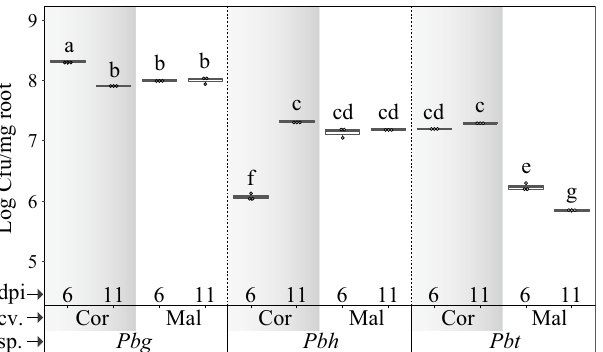
Figure 2. Root colonization ability of strains of three Paraburkholderia species (sp) for two Broccoli cultivars (cv) at 6 and 11 days post inoculation (dpi). Means of 3 replicates are shown. Treatments sharing the same letter are not significantly different based on three-ways ANOVA (dpi, Broccoli cultivars and Bacteria species, Tukey’s HSD post hoc test, P < 0.05). Broccoli cultivars (Cor: Coronado, Mal: Malibu) and Paraburkholderia species ( Pbg : Paraburkholderia graminis PHS1, Pbh : P. hospita mHSR1, and Pbt : P. terricola